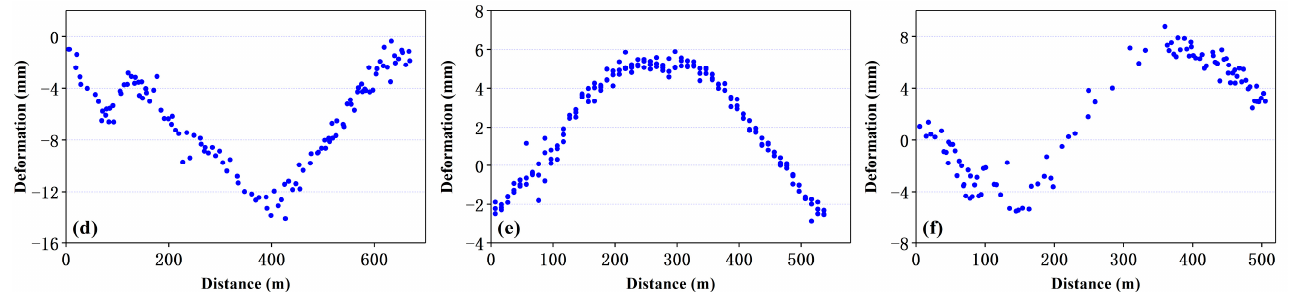
Figure 11. Deformation field of ( a ) Inglewood oilfield; ( b ) Santa Fe Springs oilfield; and ( c ) Wilming- ton oilfield. ( d – f ): the corresponding deformation rate extracted along the profile.